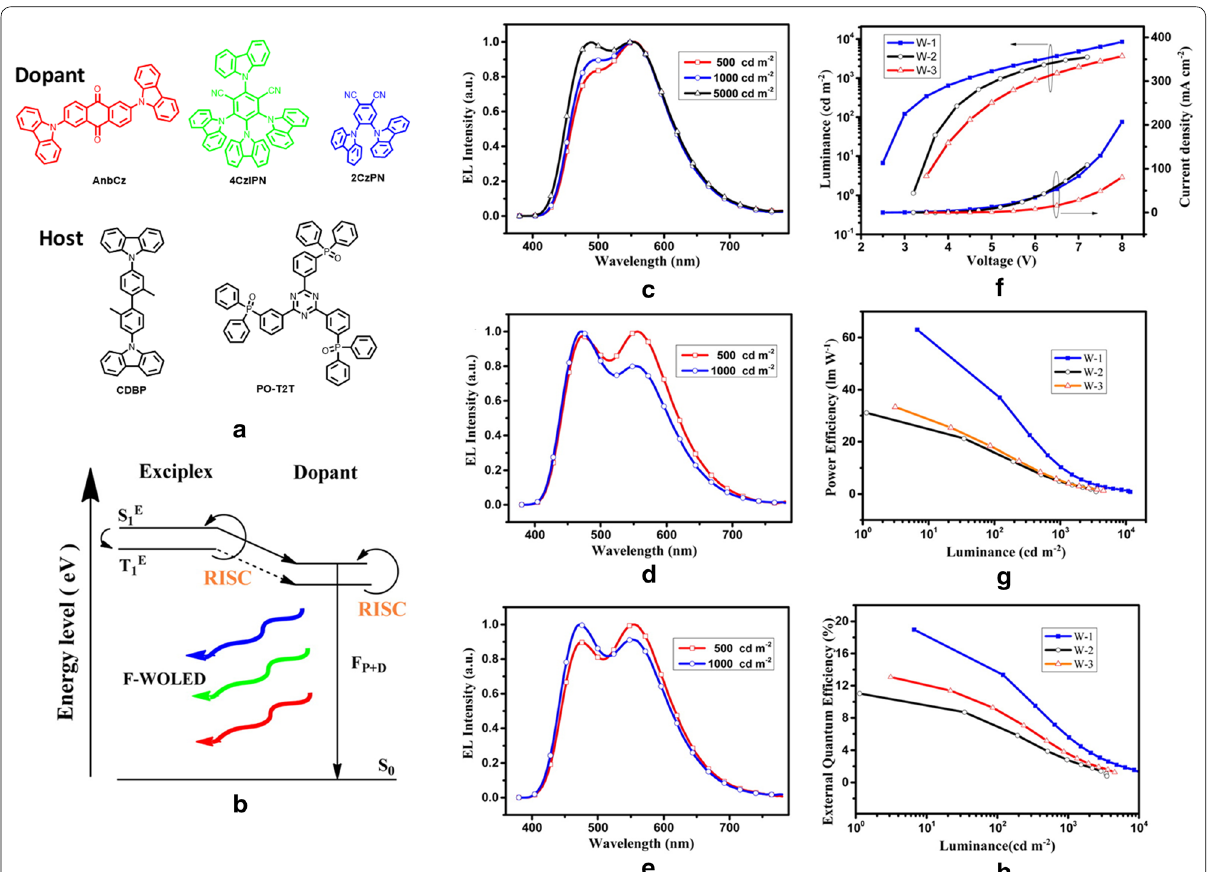
Fig. 18 a Chemical structures of emitter dopants and hosts. b Energy transfer mechanism of the TADF emitters with exciplex host (solid arrow indicates FRET and broken line arrow indicates DET). EL spectra of the devices at varying luminance c devices W-1, d W-2, and e W-3, f current density (J–V) vs. luminance characteristics, g PE-luminance and h EQE vs. luminance plots of the three fabricated